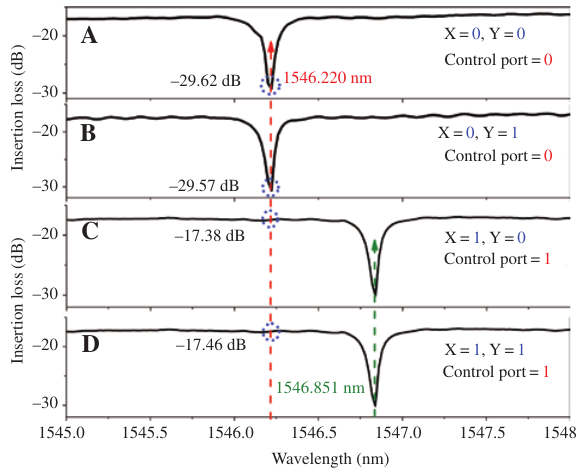
Figure 3: Response spectra of the device at the Control port with the applied voltages to the micro-heaters over MRR (A) 0 V and 0.55 V, (B) 0 V and 1.71 V, (C) 1.93 V and 0.55 V, (D) 1.93